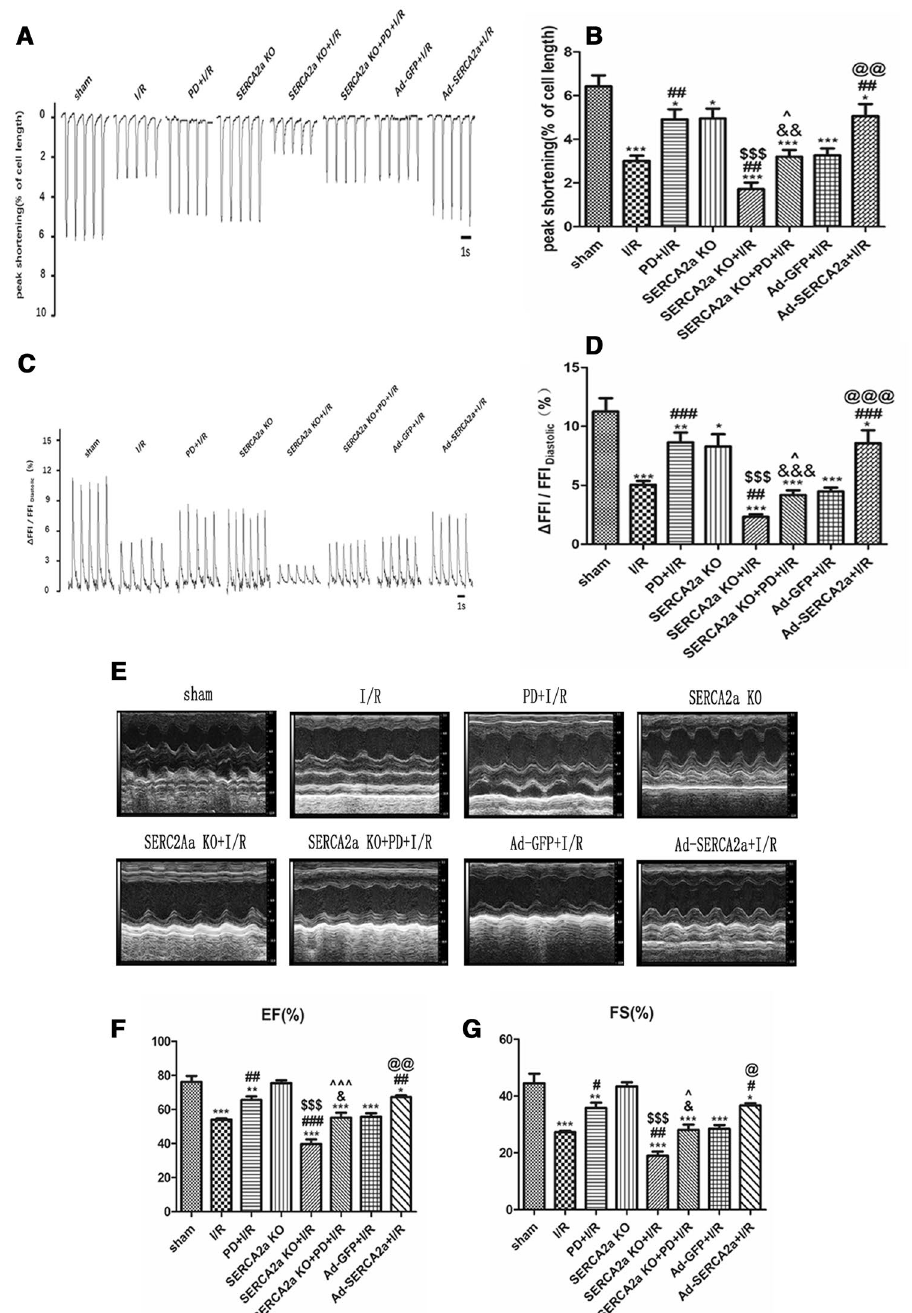
Figure 5. SERCA2a ameliorated contractility /calcium transient of cardiomyocytes and cardiac function in vivo via calpain/JPH2/T-tubule in myocardial I/R mice. ( A ) Representative contractility tracings in each group. n = 11 to 22 cells from 3–5 hearts per group; mean ± SEM. ( B ) Summary data of contractility in each group. ( C ) Representative Ca 2+ transient tracings in each group. n = 11 to 22 cells from 3–5 hearts per group ; mean ± SEM. (D) Summary data of Ca 2+ transient amplitudes in each group. ( E ) Representative M-mode transthoracic views in each group. n = 4–6; mean ± SEM. ( F , G ) Summary data of cardiac function (EF, FS). Individual data points are presented in Supplemental Fig. 5B/D/E. * P < 0.05, ** P < 0.01, *** P < 0.001 versus sham; # P < 0.05, ## P < 0.01, ### P < 0.001 versus I/R; & P < 0.05, && P < 0.01, &&& P < 0.001 versus PD + I/R; $$$ P < 0.001 versus SERCA2a KO; ^ P < 0.05, ^^^ P < 0.001 versus SERCA2a KO + I/R; @ P < 0.05, @@ P < 0.01, @@@ P < 0.001 versus Ad-GFP +